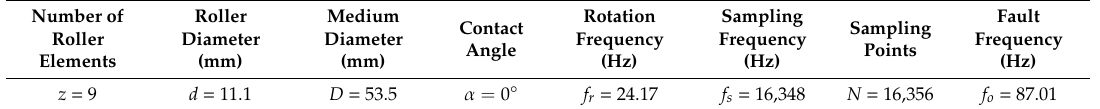
Table 3. Parameters of the faulty bearing.